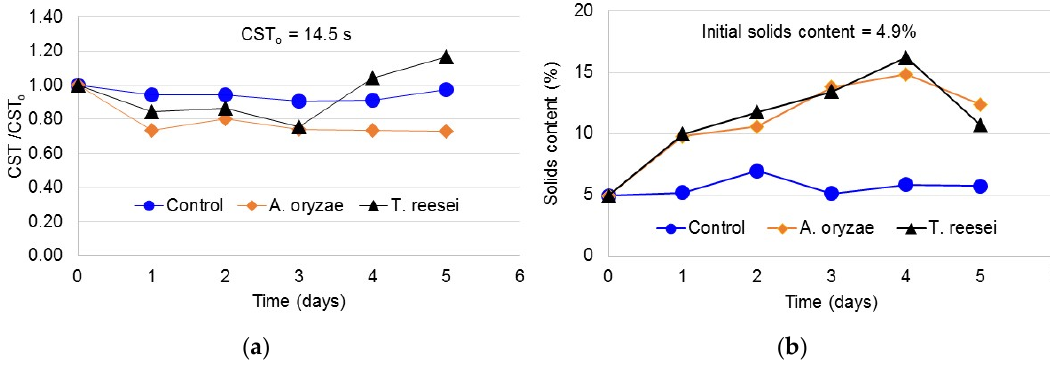
Figure 1. Effect of fungal conditioning on the activated sludge dewaterability. ( a ) Evolution of CST/CST 0 ; ( b ) Evolution of solids content.